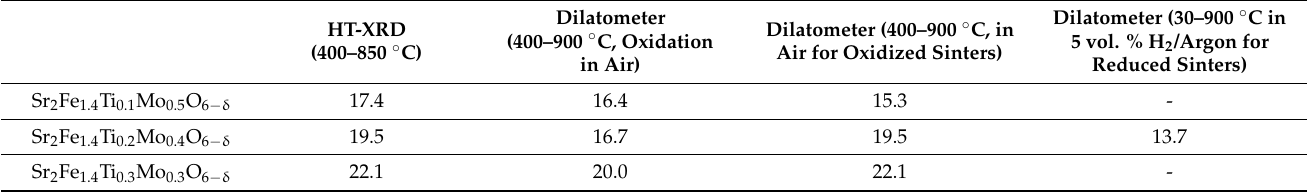
Table 2. Thermal expansion coefficients TEC [10 − 6 K − 1 ] of Sr 2 Fe 1.4 Ti x Mo 0.6 − x O 6 − δ (x = 0.1, 0.2 and 0.3) sinters from dilatometry studies and HT-XRD studies in air.